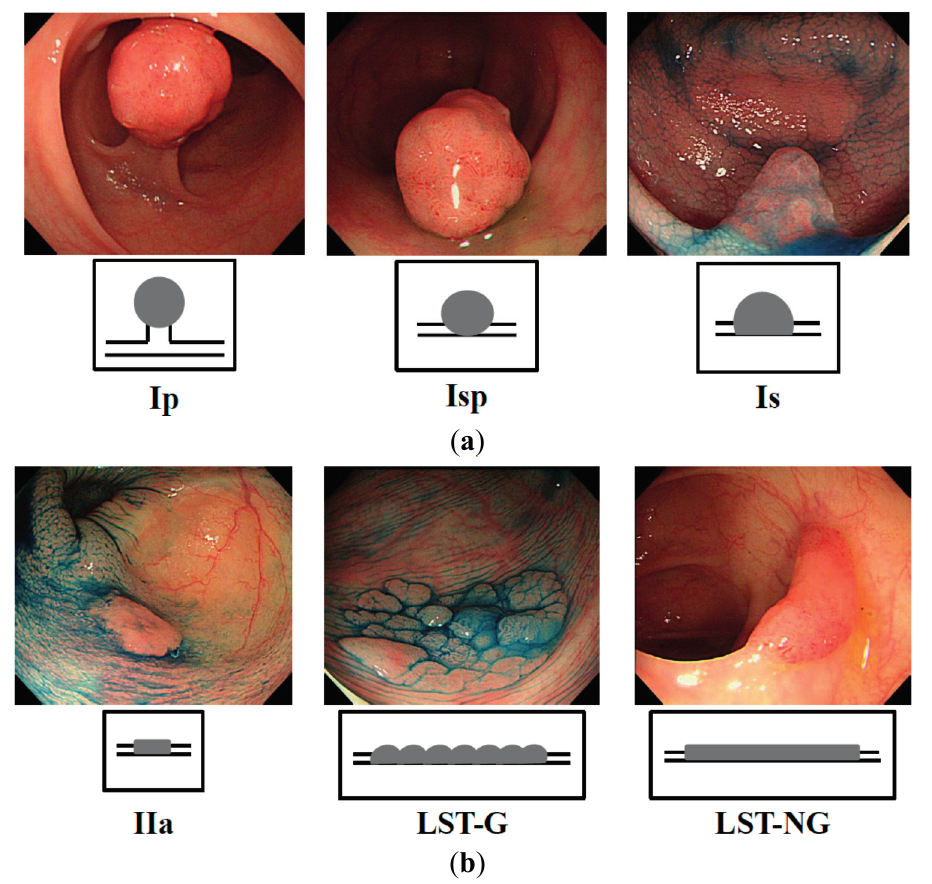
Figure 1. Endoscopic appearance of exophytic and flat elevated tumors (Japanese classification of colorectal carcinoma (8th ed.)) [30]. ( a ) Exophytic type: Ip = pedunculated type; Isp = semipedunculated type; Is = sessile type; and ( b ) Flat elevated type: IIa = superficial elevated type; LST-G = laterally spreading tumor, granular type; LST-NG = laterally spreading tumor, non-granular